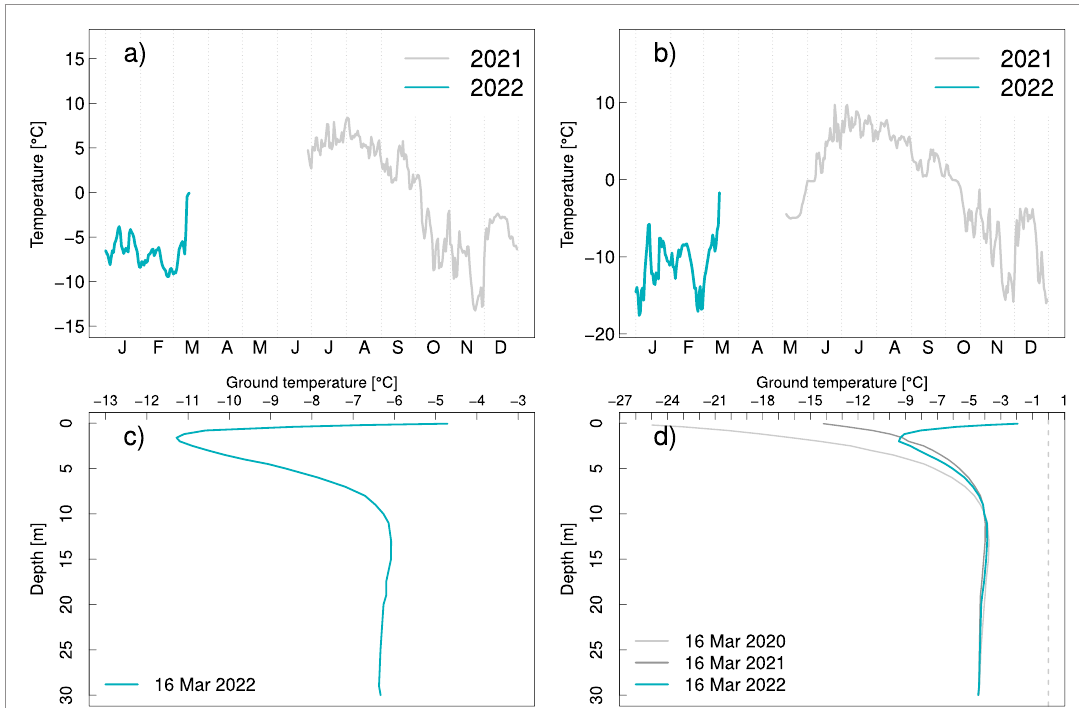
Figure 7. Warm spell in near-surface ground temperature on Svalbard on 16 March 2022. Ground temperature for Kvadehuken at 0.05 m depth (a), ground temperature for Nedre Sassendalen at 0.05 m depth (b), ground temperature profile for Klauva (c) and Verlegenhuken (d). The year 2022 is shown in blue, while past years (if available) are shown in